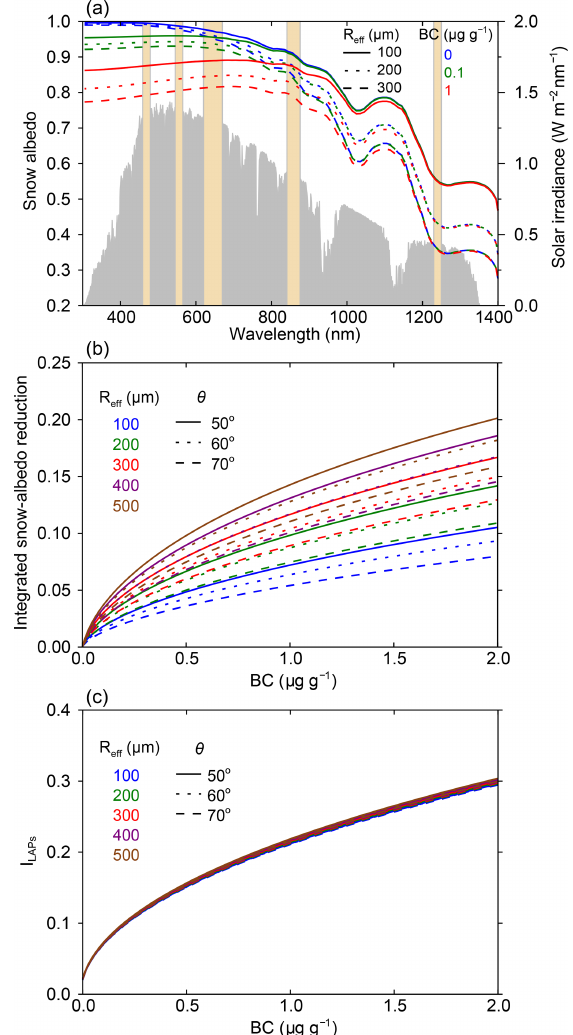
Figure 1. (a) The spectral albedo of snow with different R eff values and BC contents simulated using SNICAR. The column bars rep- resent MODIS bands, and the gray areas represent the typical solar irradiance in winter in NEC. (b) The reduction in the 300–1240nm spectral-weighted integrated snow albedo as a function of BC for different R eff values and solar zenith angles ( θ ) is simulated using SNICAR. (c) The variations in the impurity index ( I LAPs ) with BC content are simulated using